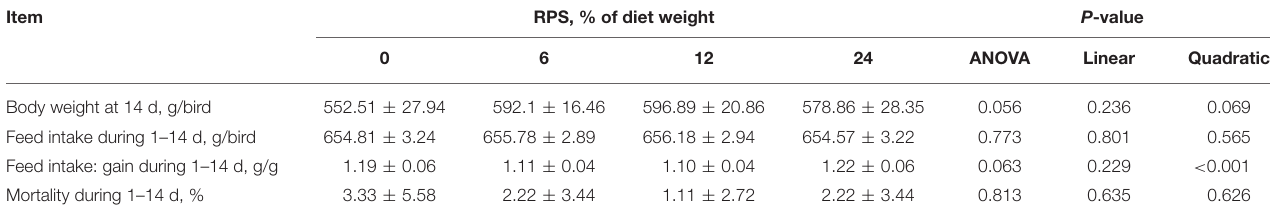
TABLE 3 | Effect of dietary raw potato starch (RPS) supplementation on growth performance for meat